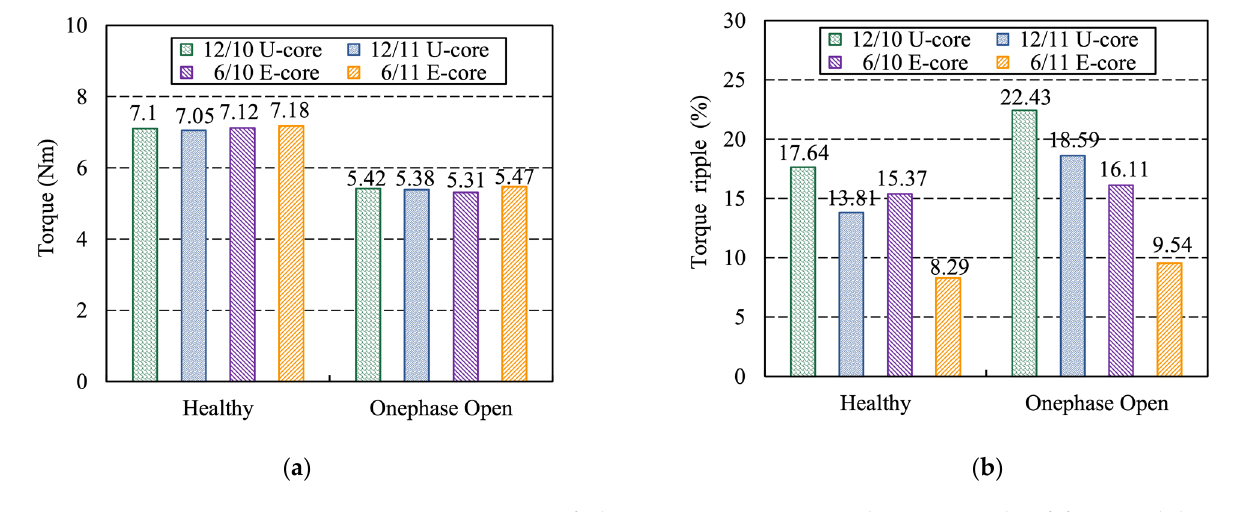
Figure 12. Comparison of electromagnetic torque and torque ripple of four candidates. between healthy and one-phase open fault-tolerant control operation. ( a ) Average electromagnetic torque; ( b ) Torque ripple.